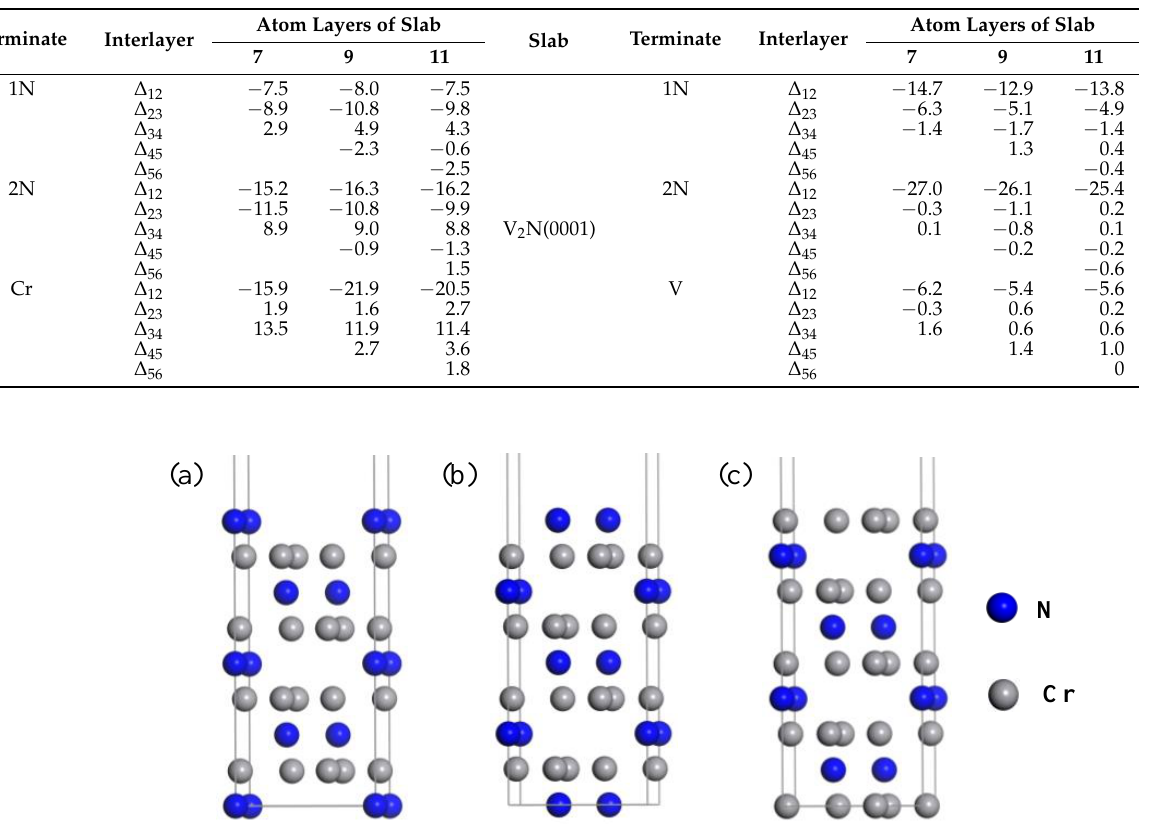
Table 2. Cr 2 N(0001) and V 2 N(0001) surface relaxations as a function of termination and slab thickness (change of the interlayer spacing ∆ ij as a percentage of the spacing in bulk).